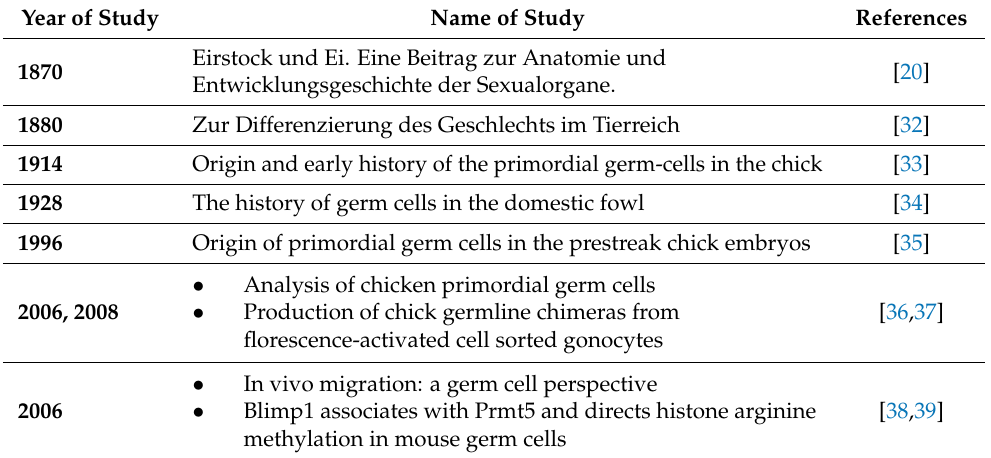
Table 1. Early studies in the development of PGCs.